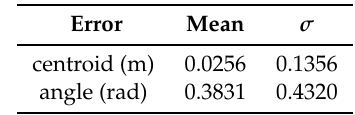
Figure 14. Error of extracted objects’ centroid ( left ) and orientation ( right ). The moment of object discovery is aligned to zero on the abscissa. If an object disappears from the view, its plot ends but its last pose is kept. Table 3. Centroid and orientation error of the extracted